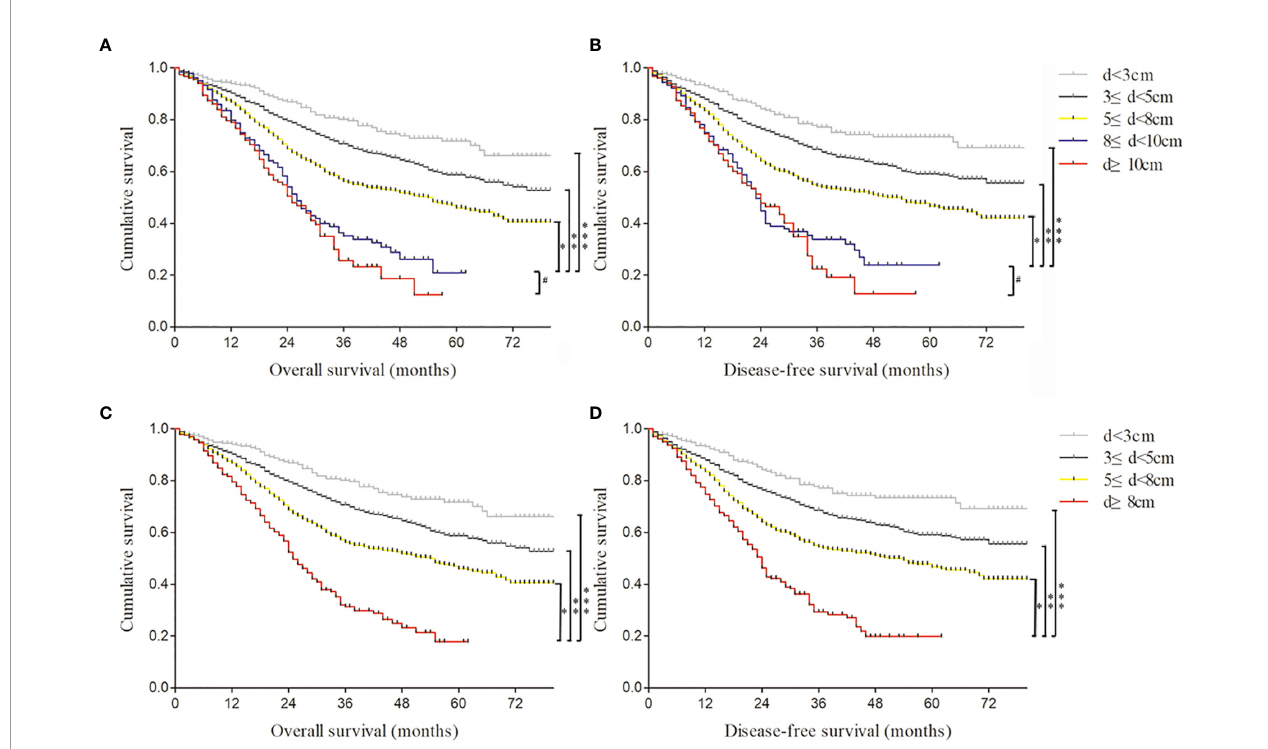
FIGURE 2 | The Kaplan – Meier curves were used to estimate different survival rates of 2,684 gastric cancer (GC) specimens grouped by observed tumor size. (A) The overall survival of 2,684 GC specimens divided into fi ve groups according to the observed tumor size. *, **, ***log rank p < 0.001; #log rank p = 0.248. (B) The disease-free survival of 2,684 GC specimens divided into fi ve groups according to the observed tumor size. *, **, ***log rank p < 0.001; #log rank p = 0.534. (C) The overall survival of 2,684 GC specimens divided into four groups according to the observed tumor size. *, **, ***log rank p < 0.001. (D) The disease-free survival of 2,684 GC specimens divided into four groups according to the observed tumor size. *, **, ***log rank p <